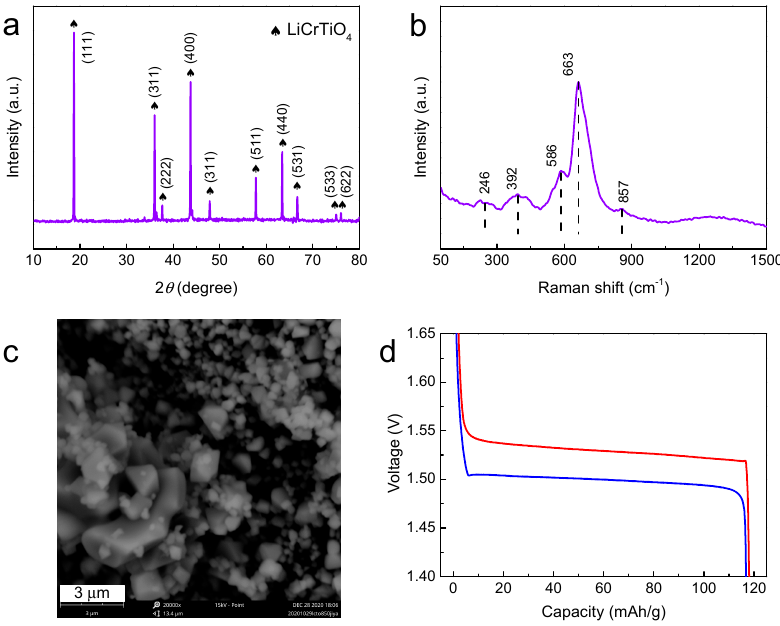
Figure 8. ( a ) The XRD pattern, ( b ) the Raman spectrum, ( c ) the SEM image and ( d ) the galvanostatic discharge/charge curves of LiCrTiO 4 sintered in a pellet form at a temperature of 850 °C. The XPS measurement was adopted to analyze the difference between LiC- rTiO 4 -850-powder and LiCrTiO 4 -850-pellet, as shown in Figure 9. The Li 1s peak at ca. 54.7 eV was observed for both samples, as shown in Figure 9a [32]. There are four binding energies: 576.4 eV for Cr 3+ 2p 3/2 , 579.6 eV for Cr 6+ 2p 3/2 , 586.3 eV for Cr 3+ 2p 1/2 and 588.9 eV for Cr 6+ 2p 1/2 , as shown in Figure 9b [33–35]. The ratio between Cr 6+ and Cr 3+ is 0.735:1 for LiCrTiO 4 -850-powder and 0.632:1 for the LiCrTiO 4 -850-pellet, according to their peak areas. The Cr element exists in the form of Cr 3+ in spinel LiCrTiO 4 , and the Cr 6+ ions on the surface should be attributed to the high-temperature sintering in air atmosphere, espe- cially for LiCrTiO 4 -850-powder. As shown in Figure 9c, the Ti 2p 3/2 peak at 458.4 eV and Ti 2p 1/2 peak at 464.1 eV indicate that the Ti element mainly exists in the form of Ti 4+ [36] . As for the O 1s spectra in Figure 9d, the binding energies of 529.8 eV and 531.2 eV are assigned to the lattice oxygen and the CO 3 2 − , respectively [37–39]. Here, the raw material of Li 2 CO 3 might leave the CO 32 − on the particle surface, especially for LiCrTiO 4 -850-pellet. Therefore, the LiCrTiO 4 -850-powder has more Cr 6+ and less CO 32 − on the particle surface than the LiCrTiO 4 -850-pellet, which should be correlative to the occurrence of electro- chemical oscillation. Figure 9. XPS core levels of ( a ) Li 1s; ( b ) Cr 2p; ( c ) Ti 2p, and ( d ) O 1s for LiCrTiO 4 sintered at a temperature of 850 ◦ C in a powder form (upper) and in a pellet form